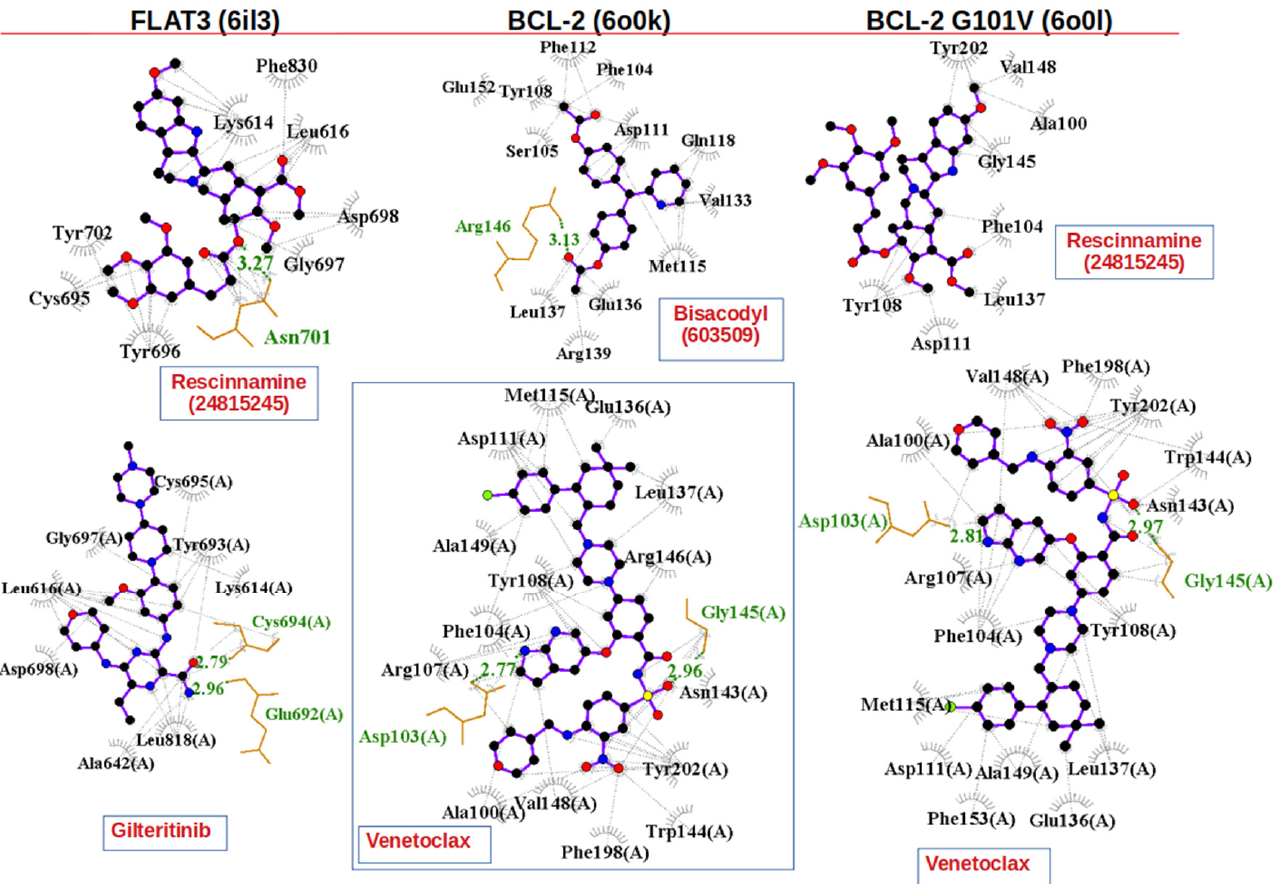
Figure 6. The docking pose binding site interaction of the rescinnamine (24815245) with FLAT 3 (6il3) and the mutated BCL-2 G101V (6o0l) and the interaction of bisacodyl (603509) with BCL-2 (6o0k), comparing the residue interaction with that of the crystal structure of the gilteritinib inter- action with FLAT3 and the venetoclax interaction with BCL-2 and the mutated BCL-2 G101V.